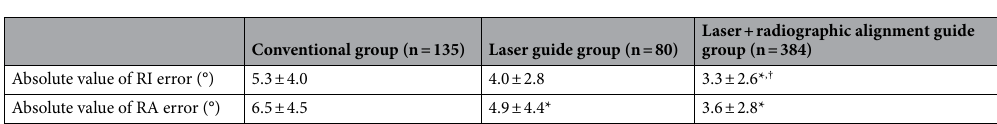
Table 2. Absolute values of RI and RA errors. Values are expressed as mean with standard deviation. *Significant compared with the conventional group. † Significant compared with laser guide group. RI radiographic inclination, RA radiographic anteversion.